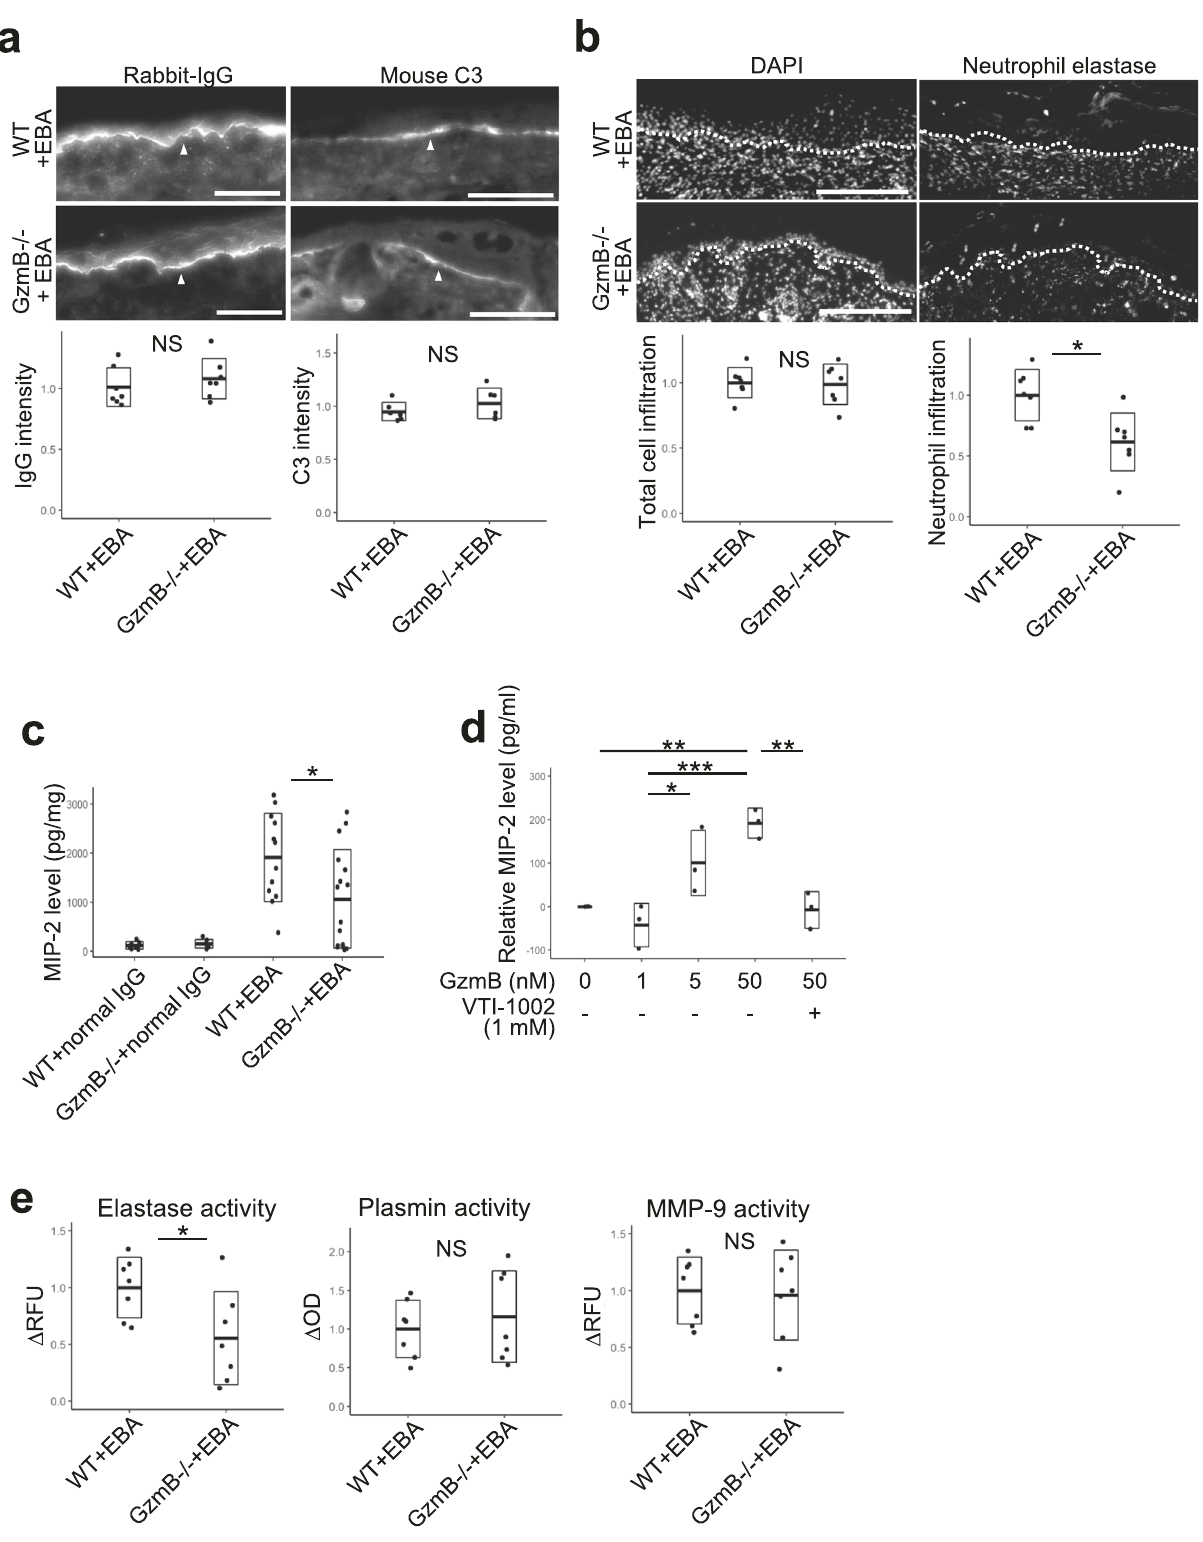
Double immunostaining of GzmB and human basophil speci fi c marker, pro-major basic protein 1 (ProMBP1) 26 , identi fi ed that varying numbers of GzmB-expressing basophils were present in the majority of patient lesional and perilesional skins (Fig. 6c, d). Based on a previous study indicating human basophils are